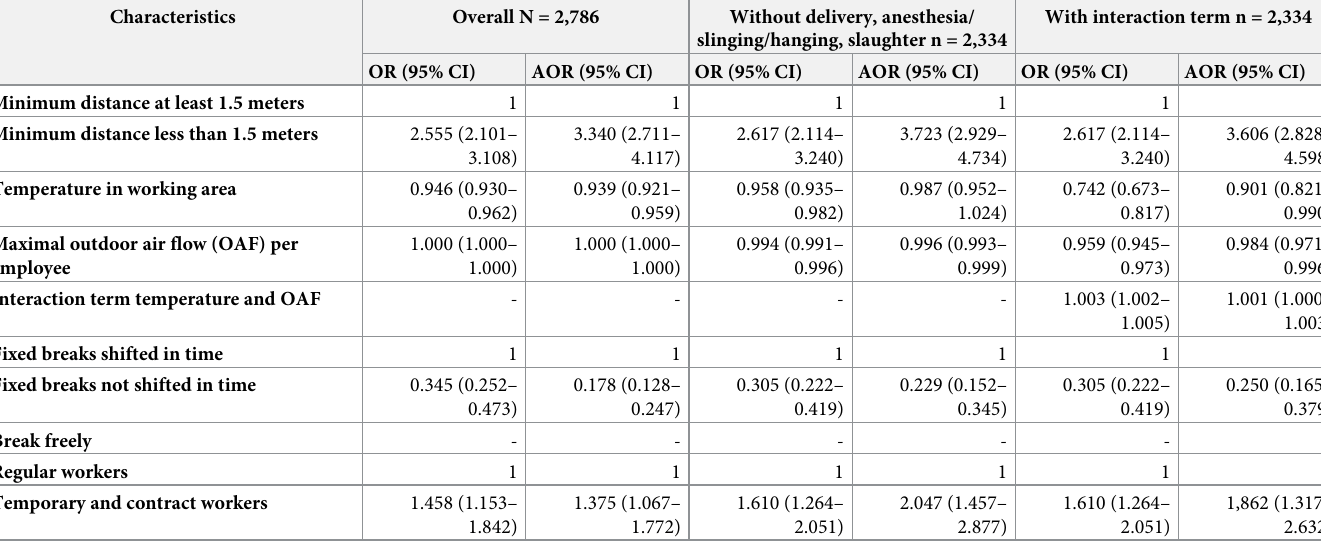
Table 6. Results of the logistic regression analysis for COVID-19 infections in the sample with information on OAF.